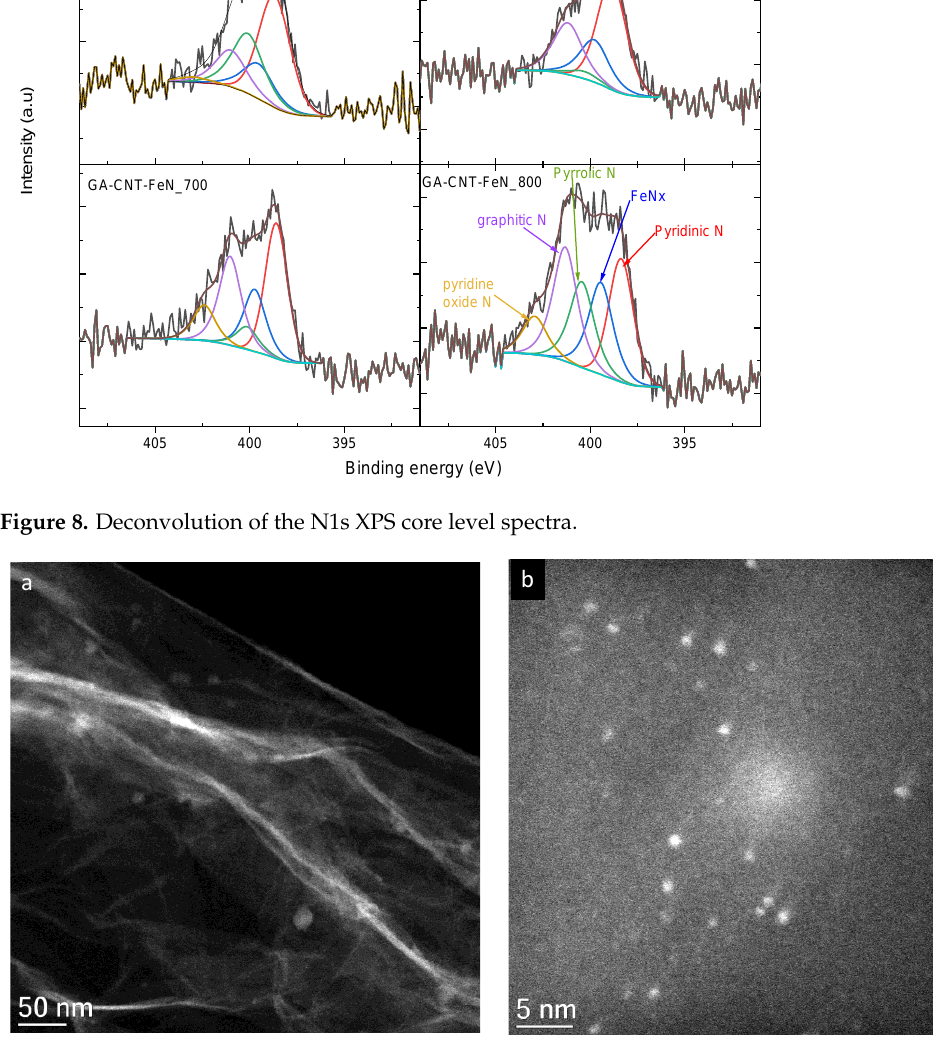
Figure 9. Representative STEM-HAADF images of catalyst GA-CNT-FeN_700 at two different magnifications: ( a ) low magnification STEM image; ( b ) high-magnification image. The lightest contrast corresponds to Fe oxide clusters or FeMx.